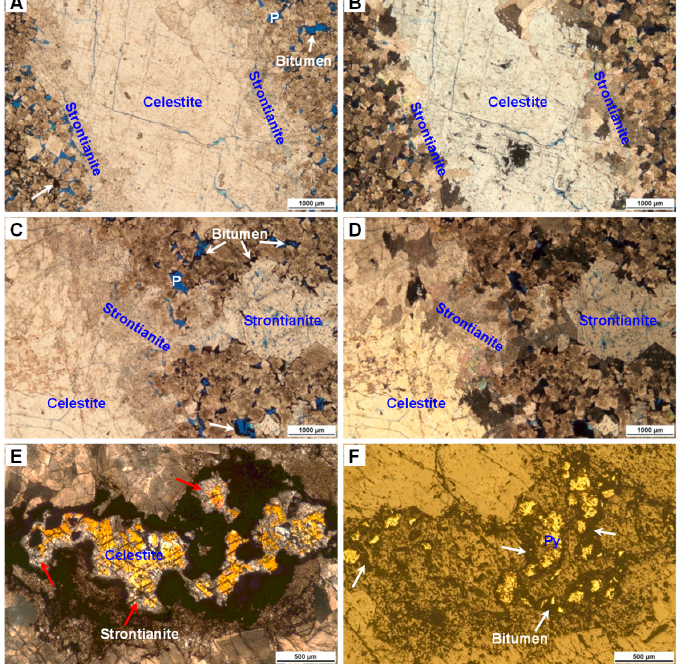
Figure 4. Thin-section photomicrographs showing the occurrence of celestites and strontianites in the YB gas field. ( A , B ) Celestite and strontianite minerals in the fracture of dolostone, 6640.15 m, P 3 c , YB29. Note the development of solid bitumens (white arrow) in the intercrystalline pores (P) of dolomite. A , under plane-polarized light (PPL); B , under Cross-polarized light (CPL). ( C , D ) Celes- tite and strontianite minerals in the dissolution fracture and pore of dolostone, 6461.73 m, P 3 c , YB205. Note the development of solid bitumens (white arrow) in the intercrystalline pores (P) of dolostone. C , under PPL; D , under CPL. ( E , F ) Celestites, strontianites (red arrow), solid bitumens (white arrow), and pyrites (Py) in the dolostone dissolution pore, 6583.10 m, P 3 c , YB2. E , under CPL; F , under reflected light.